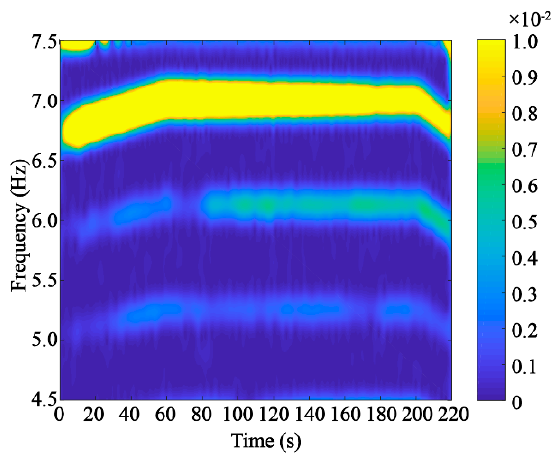
Figure 8. STFT of measured acceleration response by Sensor 1.